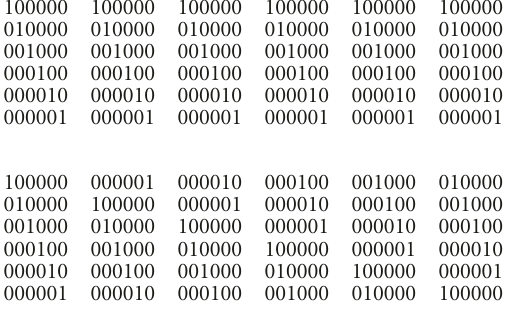
An approach for constructing LDPC codes with column weight of two has been described. Cage graphs are used to represent the code matrix, where vertices are rows and edges are columns. From known cage graphs, codes with very high girths and rates could be constructed. Some derived codes have good bit error rates compared to random codes. However, performance of each code depends on the structure of individual cage graphs from which the codes are